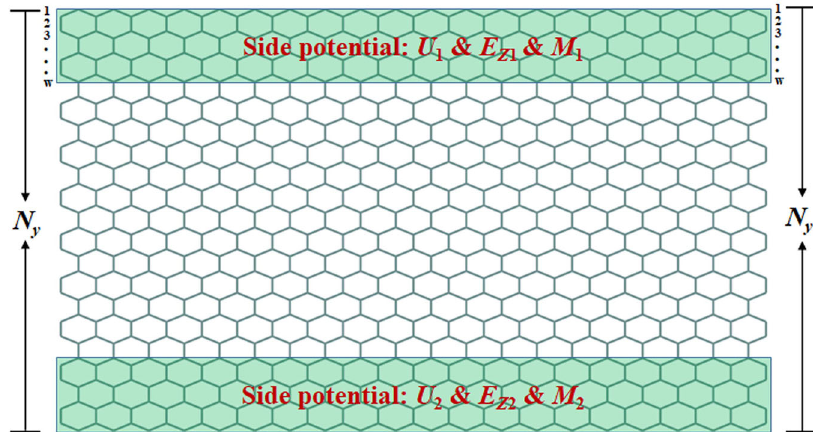
Fig. 1 Schematic plot of zigzag honeycomb nanoribbons with side potential. The side potentials include potential fi eld U 1,2 , staggered potential fi eld E Z 1,2 , and exchange fi eld M 1,2 along the boundaries. N y is de fi ned by the number of carbon atoms along the width direction, and W = 8 is the width of the side potentials.